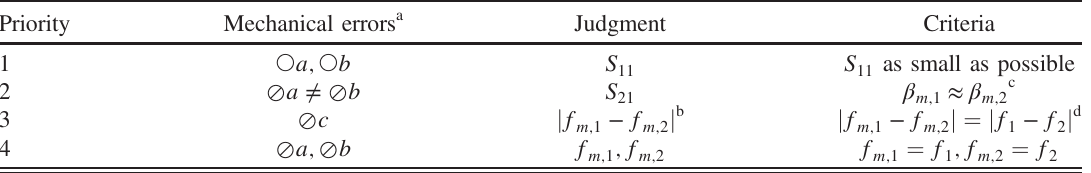
TABLE IV. Tuning strategy of a unit in the correction cavity chain.